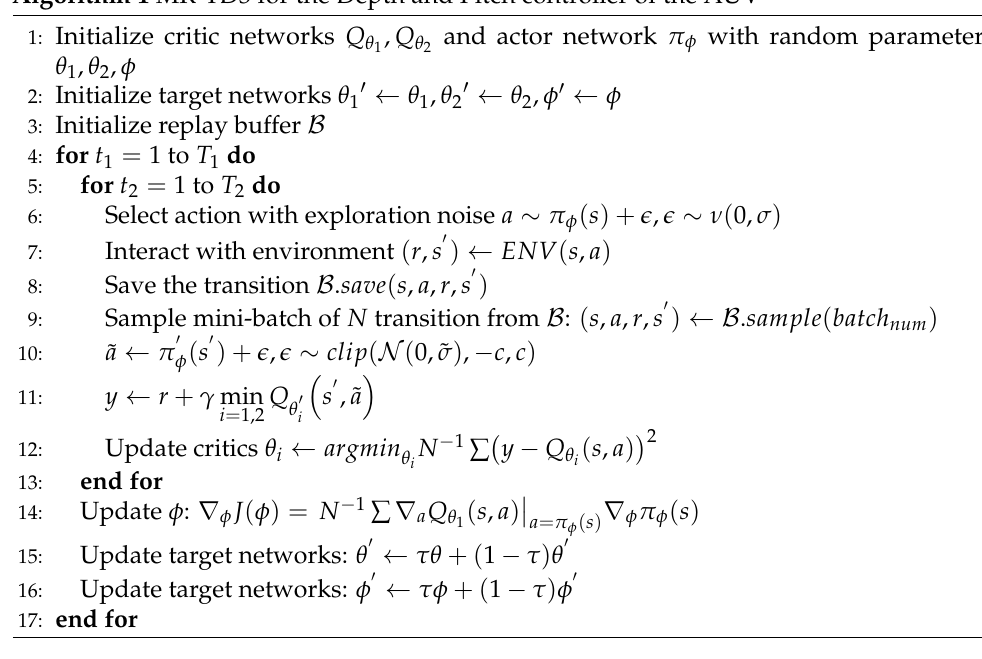
Algorithm 1 MR-TD3 for the Depth and Pitch controller of the AUV